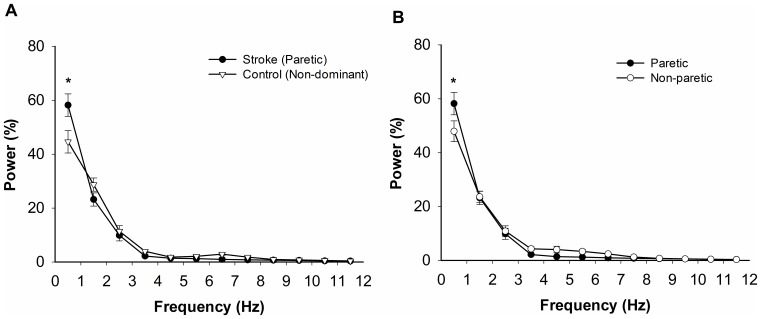
Normalized power spectrum of the force output from 0–12 Hz.The majority of the power was concentrated below 1